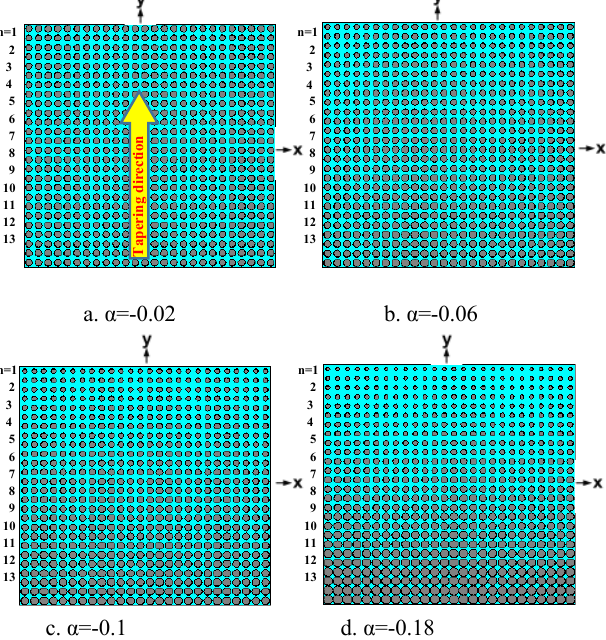
Fig. 2. A schematic diagram for the tapered via holes drilled in in one direction with α, R o = 2.64 mm, S p =7.5 mm, n =1, 2…, 13 and ζ =7 and 1 st reference element.